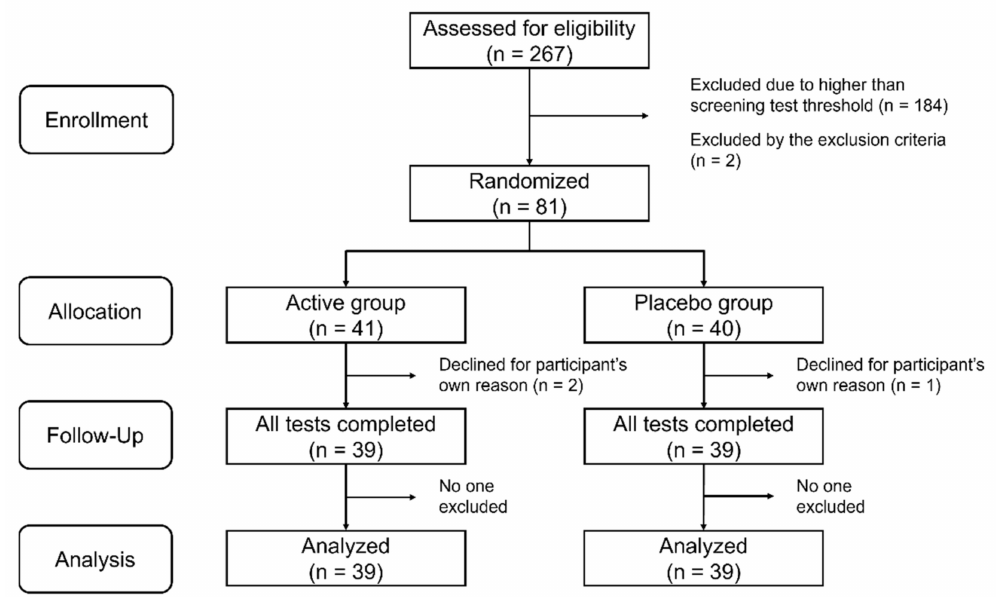
Figure 1. Flow chart showing the number of participants in the active and placebo groups at each stage of the